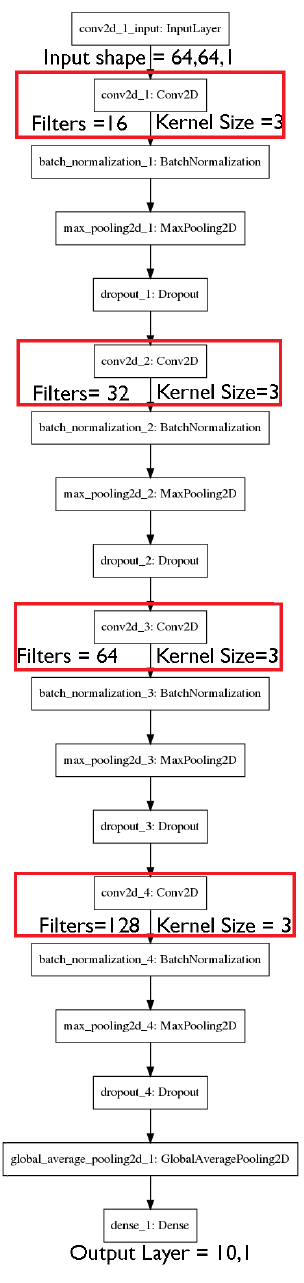
Figure 5. The CNN architecture used for digit